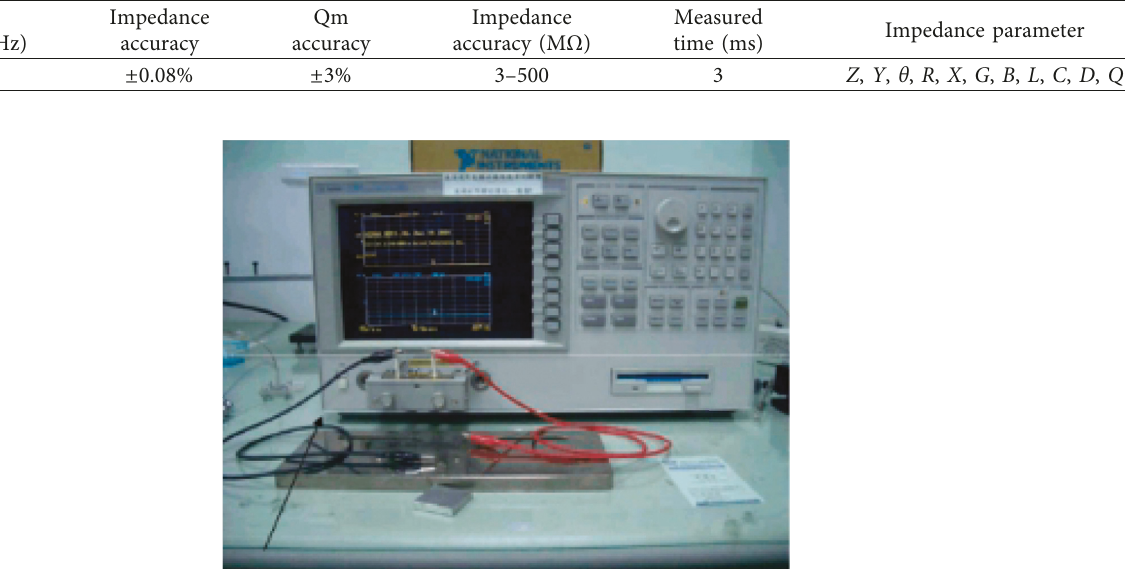
Figure 7: The frequency measuring device of the ultrasonic nozzle.